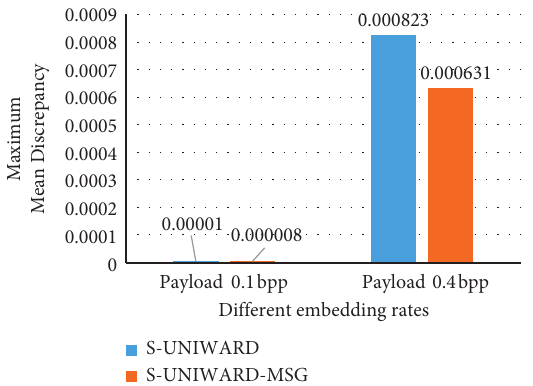
Figure 5: MMD detection results of different adaptive steganog- raphy image enhancement algorithm for spatial